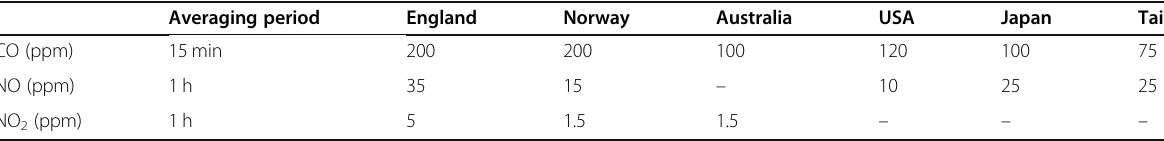
Table 2 The air quality standard of tunnel Averaging period